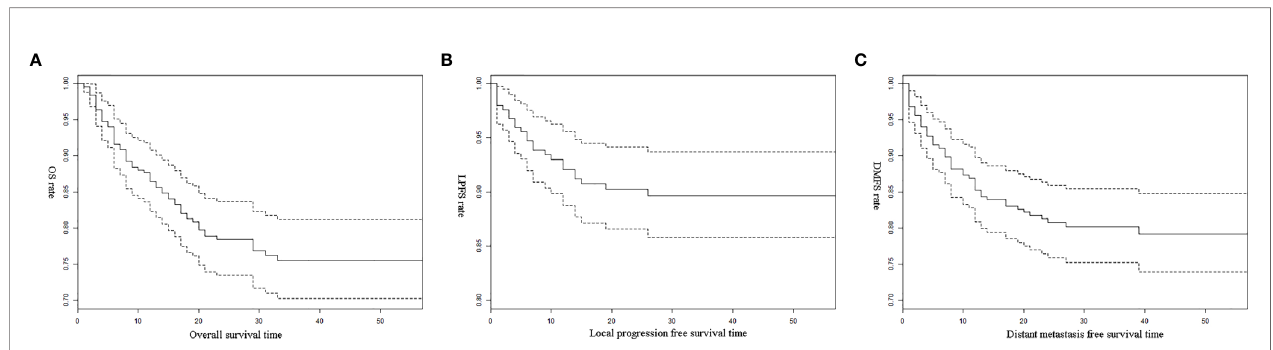
FIGURE 1 | (A) Overall survival of all patients; (B) Local progression free survival of all patients; (C) Distant metastasis free survival of all